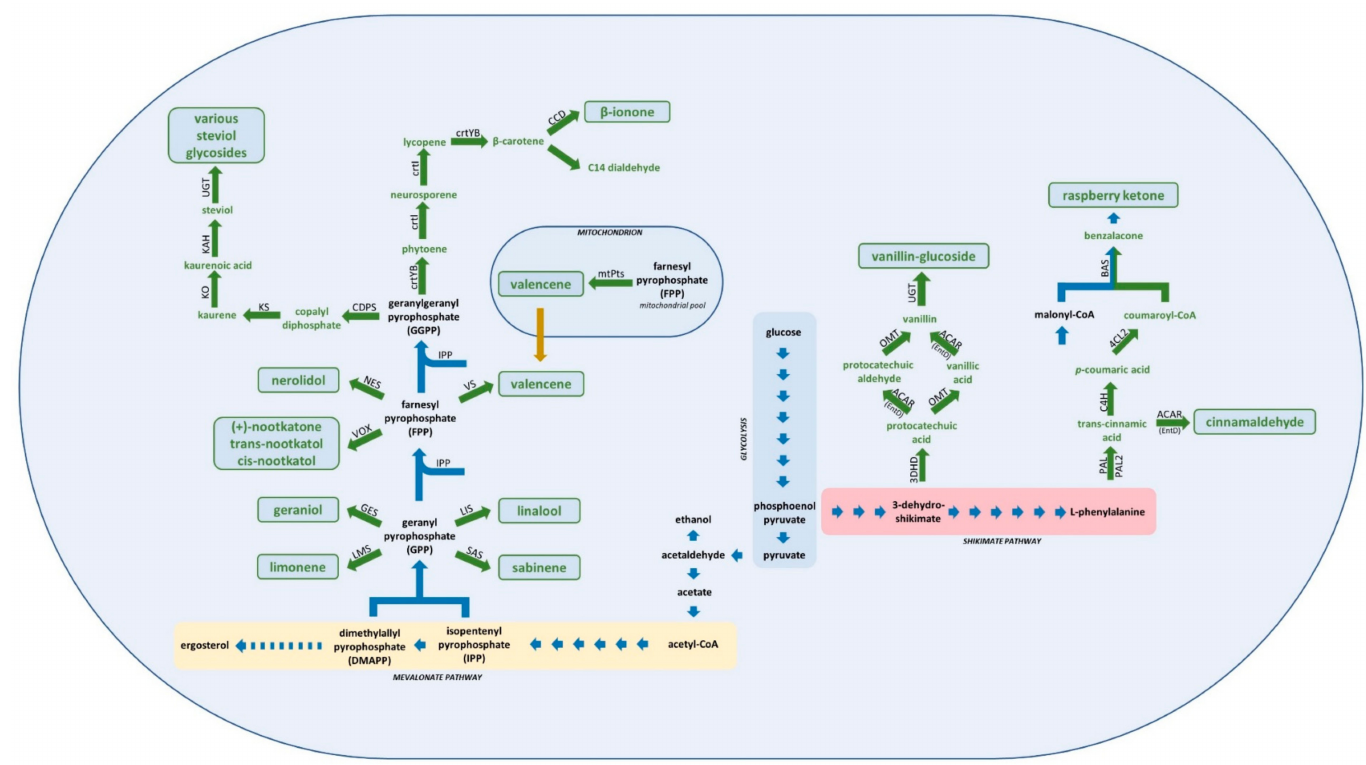
Figure 1. Simplified central metabolism of Saccharomyces cerevisiae (blue arrows), and heterologous enzymatic reactions (green arrows) leading to production of various flavour and aroma compounds: vanillin-glucoside (3DSD: 3-dehydroshikimate dehydratase, ACAR: aryl carboxylic acid reductase, OMT: O -methyltransferase, UGT: UDP-glycosyltransferase), raspberry ketone (PAL: phenylalanine/tyrosine ammonia lyase, C4H: cinnamate-4-hydroxlase, 4CL2: coumarate-CoA ligase 2, BAS: benzalacetone synthase), cinnamaldehycde (PAL2: phenylalanine ammonia lyase 2, ACAR: aryl carboxylic acid reductase, EntD: phosphopantetheinyl transferase), geraniol (GES: geraniol synthase), limonene (LMS: limonene synthase), linalool (LIS: linalool synthase), sabinene (SAS: sabinene synthase), valencene (VS: valencene synthase, mtPts: mitochondria targeted valencene synthase), (+)-nootkatone, trans -nootkatol, cis -nootkatol (VOX: (+)-valencene oxidase), nerolidol (NES: nerolidol synthase), β -ionone (crtYB: phytoene synthase/lycopene cyclase, crtI: phytoene desaturase, CCD: carotenoid cleavage dioxygenase), steviol glycosides (CDPS: copalyl diphosphate synthase, KS: kaurene synthase, KO: kaurene oxidase, KAH: kaurenoic acid-13-hydroxylase, UGT: